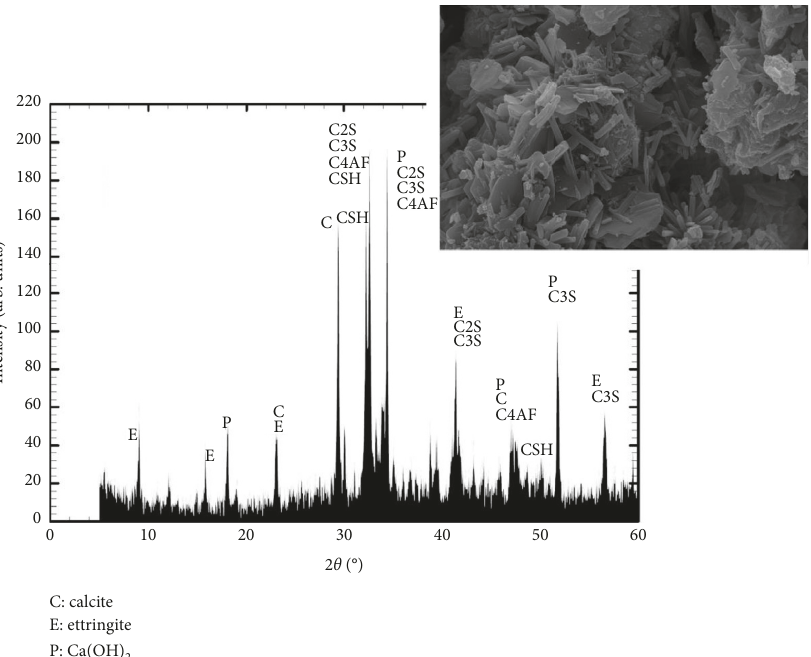
Figure 7: SEM micrographs and XRD pattern of cement paste.